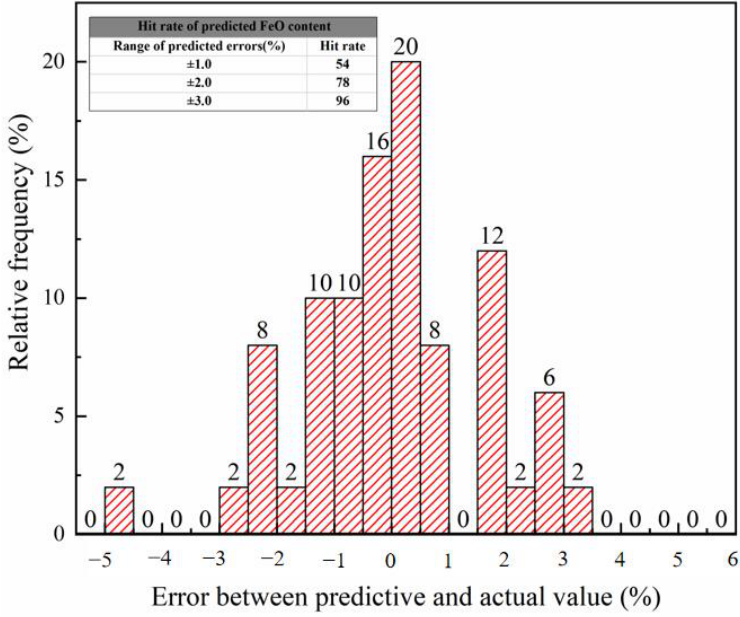
Figure 12. Error distribution of PCA-BP neural network predictive model.